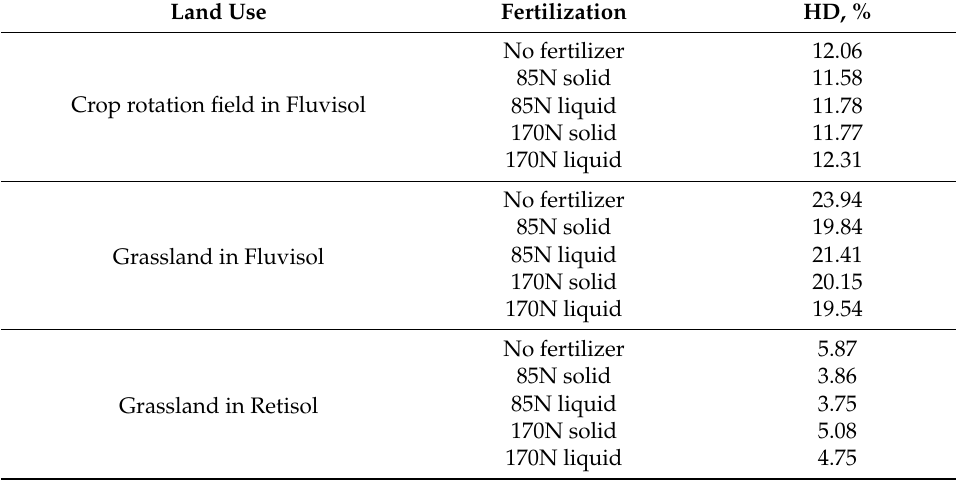
Table 2. Effect of land-use and fertilization by digestate on the humification degree (HD%) of OM, 2020. Averaged in 0–40 cm soil